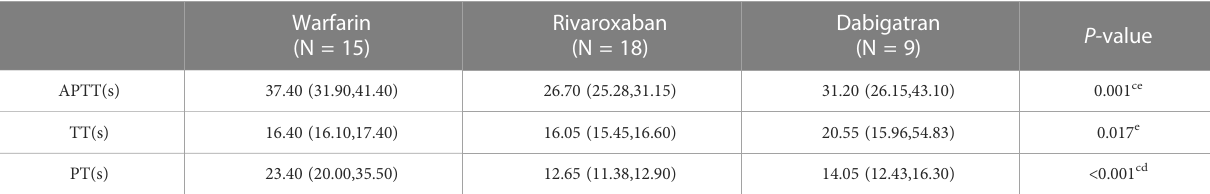
TABLE 3 The effect of different types of anticoagulants on coagulation [M(P25,